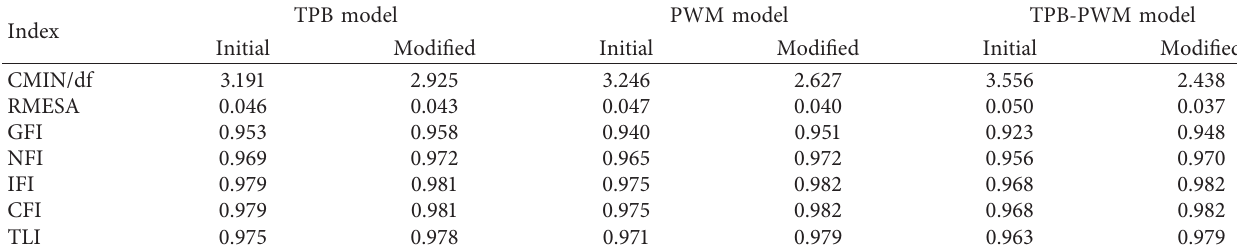
Table 3: The degree-of-fit indexes in three models.